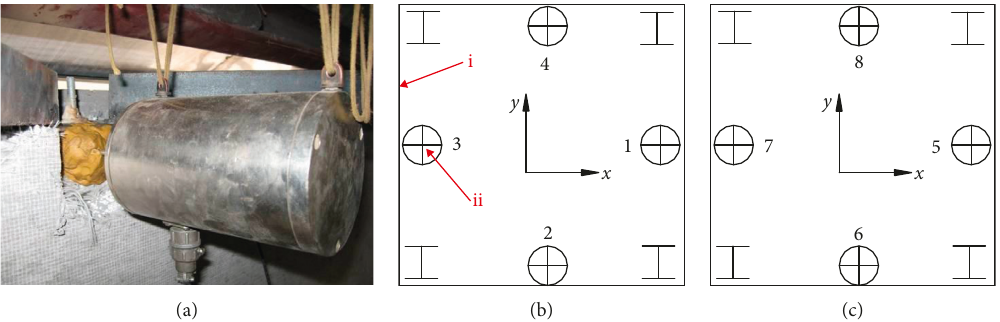
Figure 14: Arrangement of vibration exciter. (a) Vibration exciter. (b) On top of first floor: (i) beam and (ii) acceleration transducer. (c) On top of second floor.